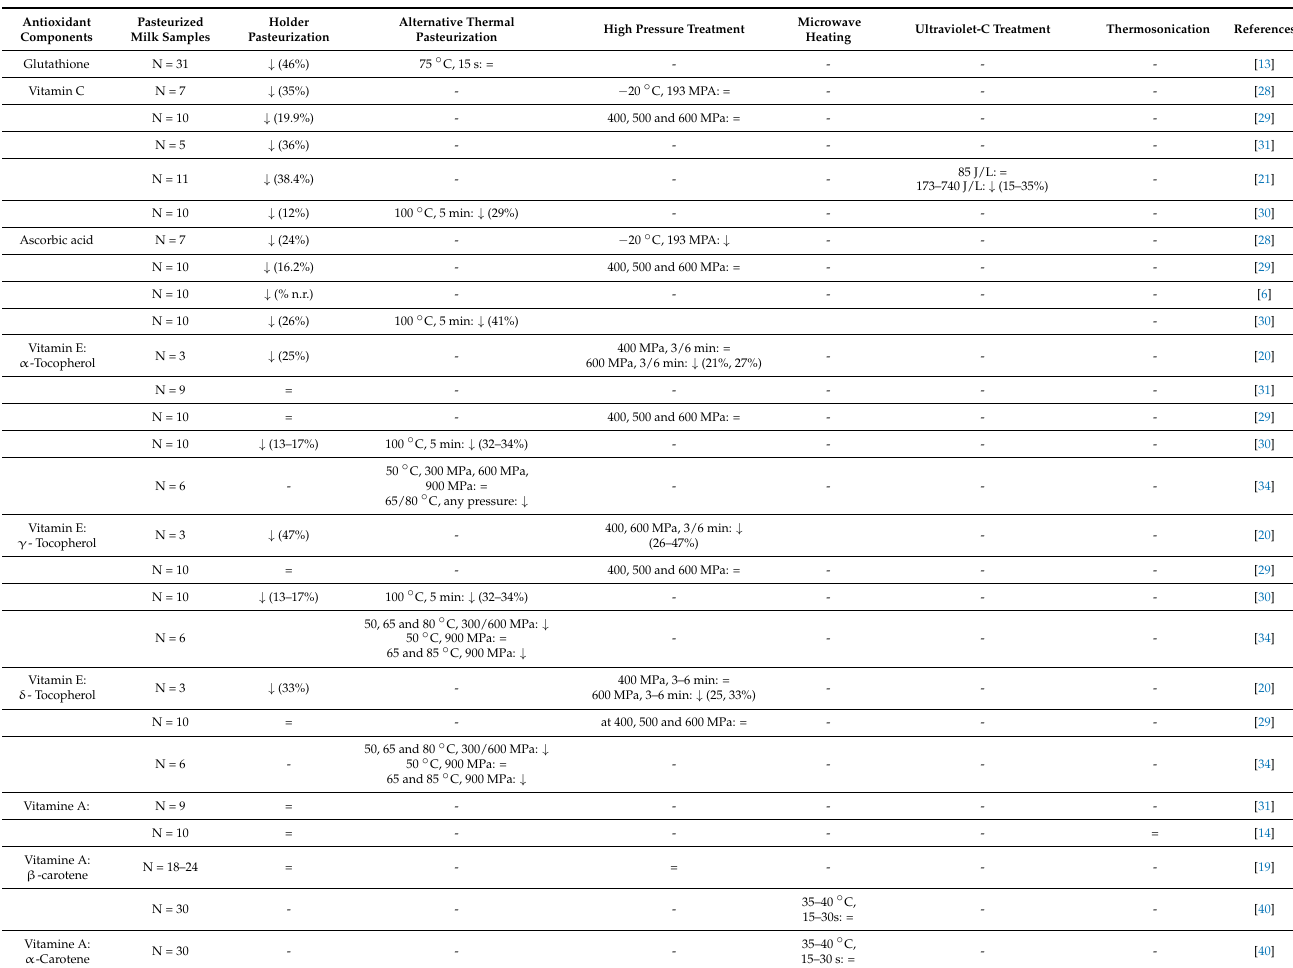
Table 3. Results of different pasteurization methods on antioxidant properties in human milk: non-enzymatic antioxidants. Antioxidant Pasteurized Components